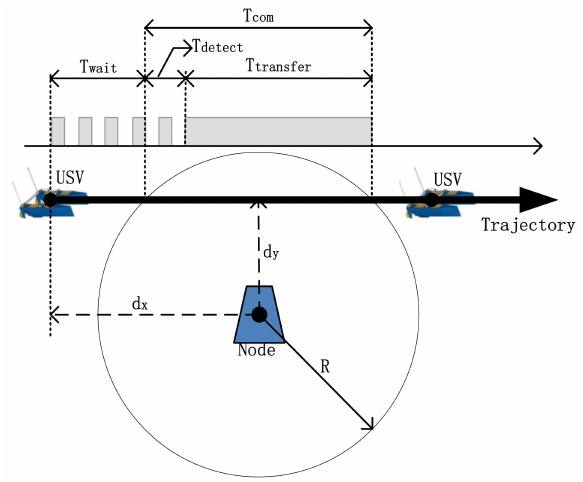
Figure 2. Point to point communication applications diagram.